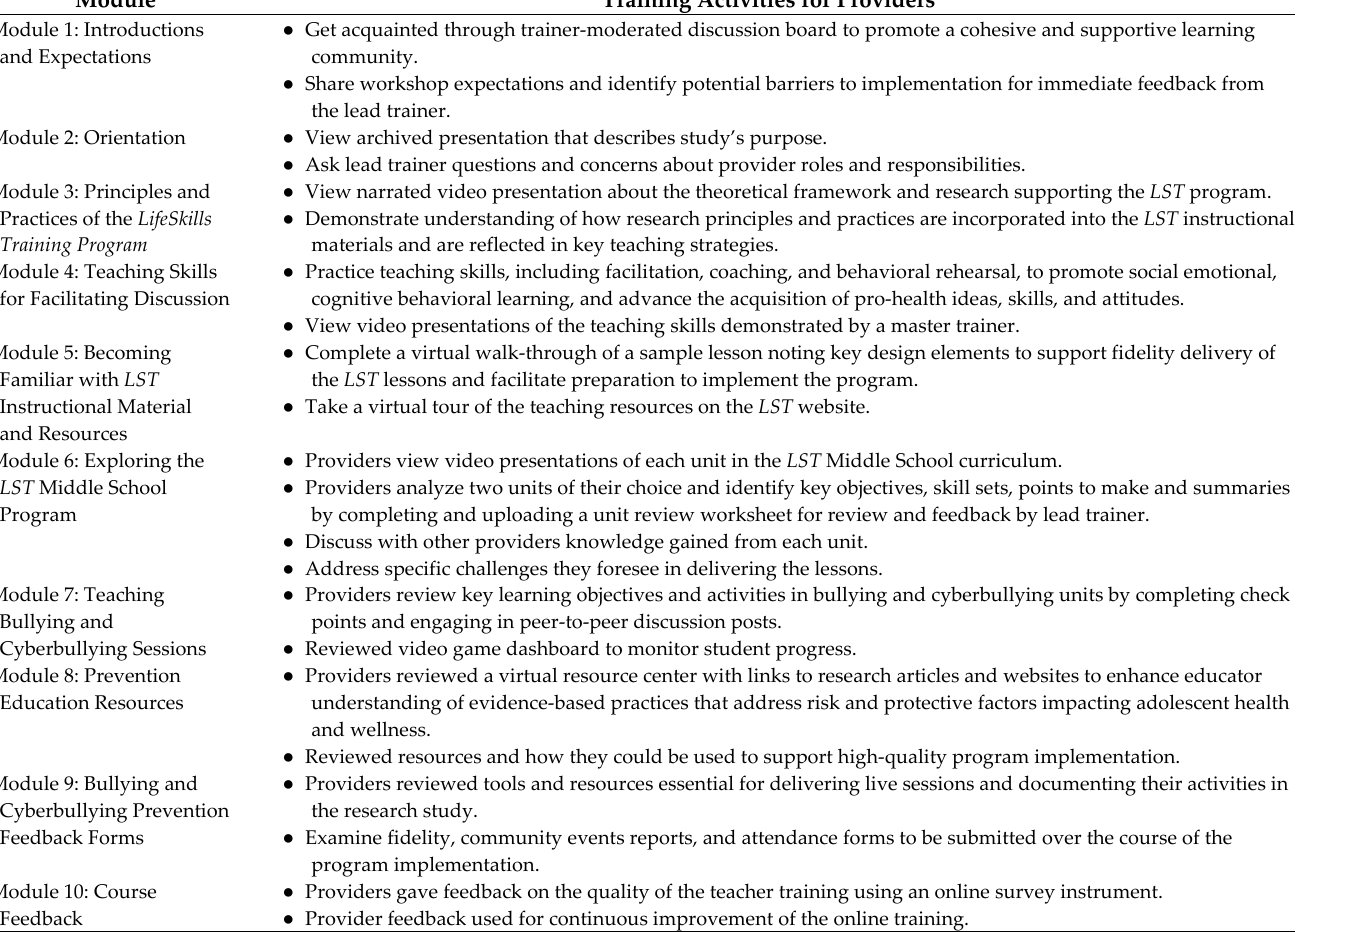
Table 3. Online Program Provider Training Workshop.